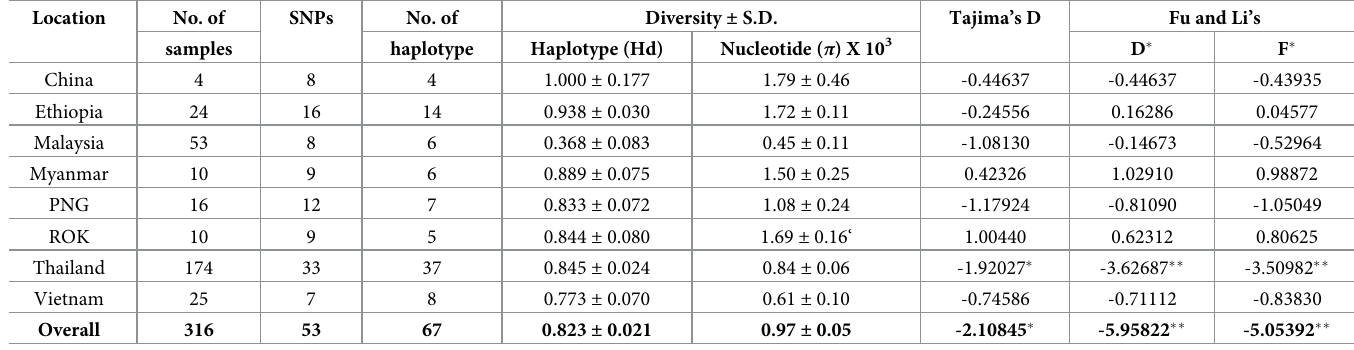
Table 1. Estimates of nucleotide diversity, haplotype diversity and neutrality indices of pvebp -ecto domain based on the geographical location. ( � p < 0.05, �� p < 0.02, ��� p <